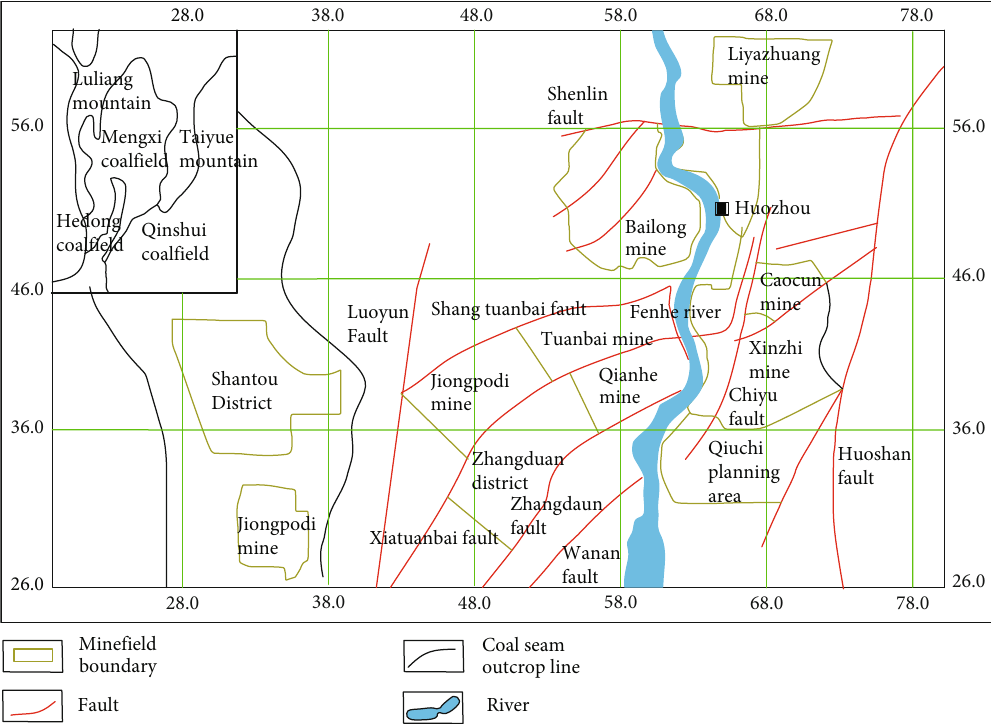
Figure 1: Regional structure sketch of the Huozhou mining